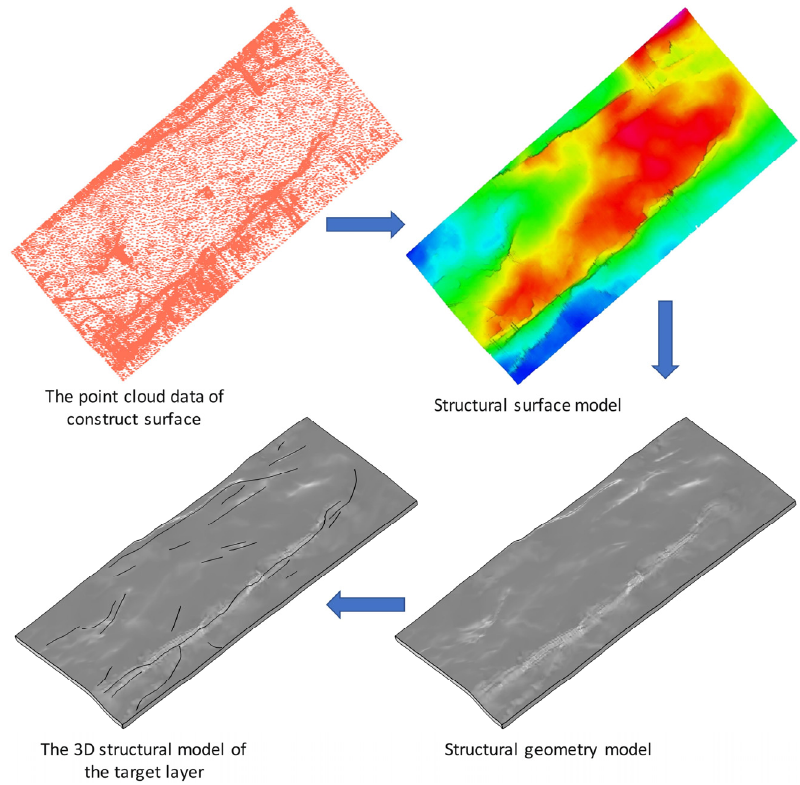
Figure 4. Construction process of the 3D construction model of the target layer.